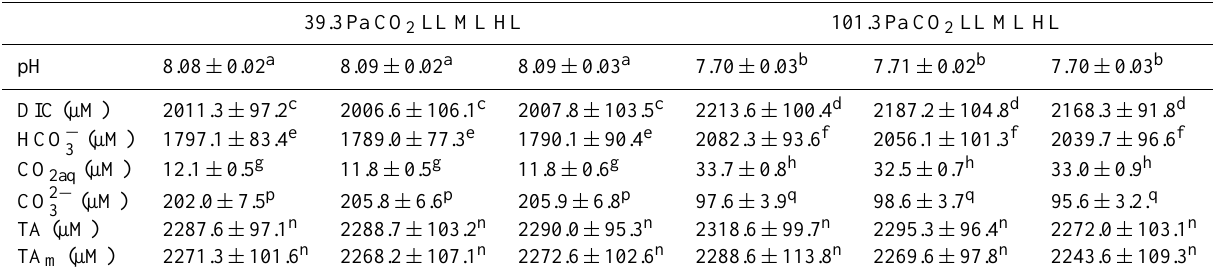
Table 1. Parameters of the seawater carbonate system under ambient (39.3Pa or 390µatm) and enriched (101.3Pa or 1000µatm) CO 2 levels in the turbidostat cultures under different photon flux densities (LL: 25; ML: 200; HL: 800µmol photonsm − 2 s − 1 ) of PAR. Dissolved inorganic carbon (DIC), pH, salinity (33‰), nutrient concentration (phosphate, 3.6; silicate, 11.3; nitrate, 882.4µM) and temperature (20 ◦ C) were used to derive all other parameters using the CO 2 system analyzing software CO2SYS. The stoichiometric equilibrium constants K 1 and K 2 for carbonic acid used were 6.04 and 9.16, respectively. The data represents the mean ± SD ( n = 24) except measured total alkalinity (TA m ) ( n = 9). Superscripts with different letters indicate significant differences between